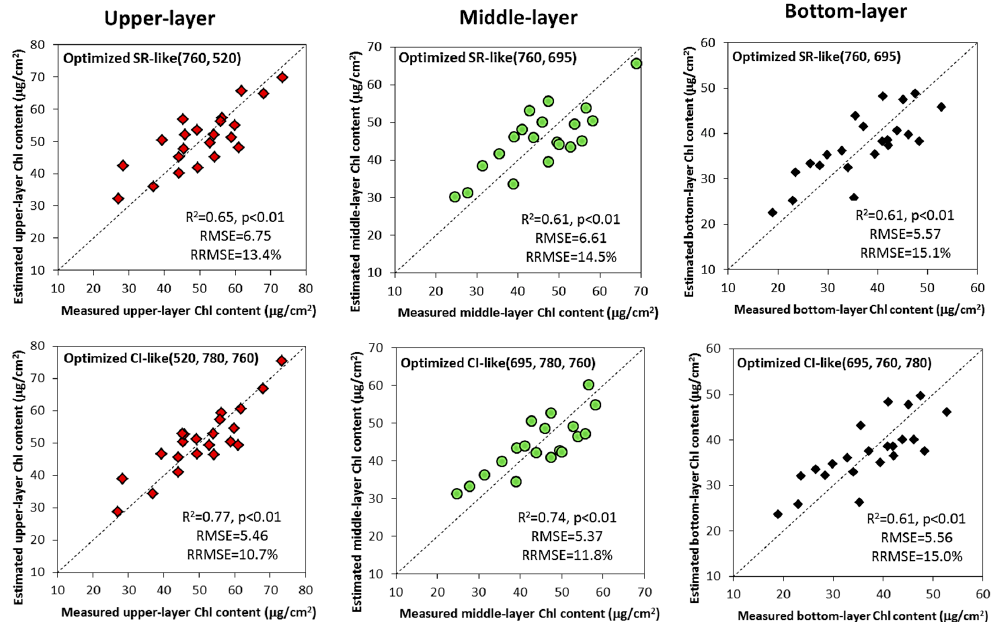
Figure 7. The comparison of validation models between the measured and estimated Chl content using the optimized spectral indices in the upper-layer (red diamonds), middle-layer (green circles) and bottom-layer (black diamonds), respectively. The predictive R 2 , p -value, RMSE and RRMSE shown refer to the validation dataset. Dotted lines are 1:1 lines.